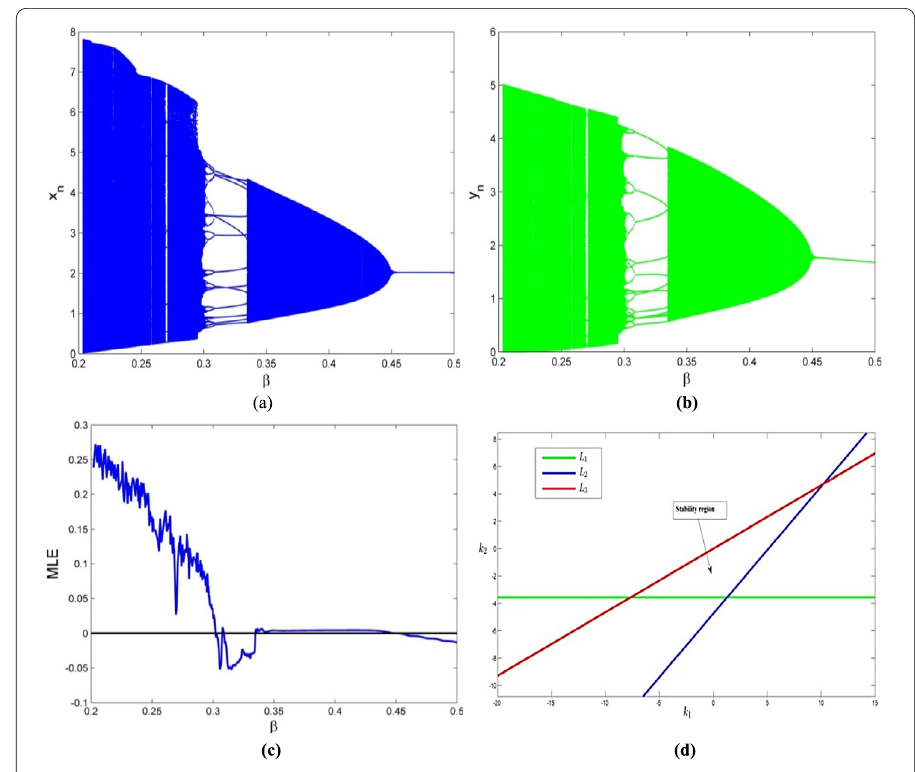
Figure 3 Bifurcation and MLE diagrams of system (4) with parametric values r = 0.2, b = 2.5, c = 0.01, d = 0.5, α = 1.02, γ = 0.1, β ∈ [0.2,0.5], and ( x 0 , y 0 ) = (2.01,1.7). ( a ) Bifurcation diagram for x n ( b ) Bifurcation diagram for y n ( c ) MLE ( d ) Stability region for controlled system (37)